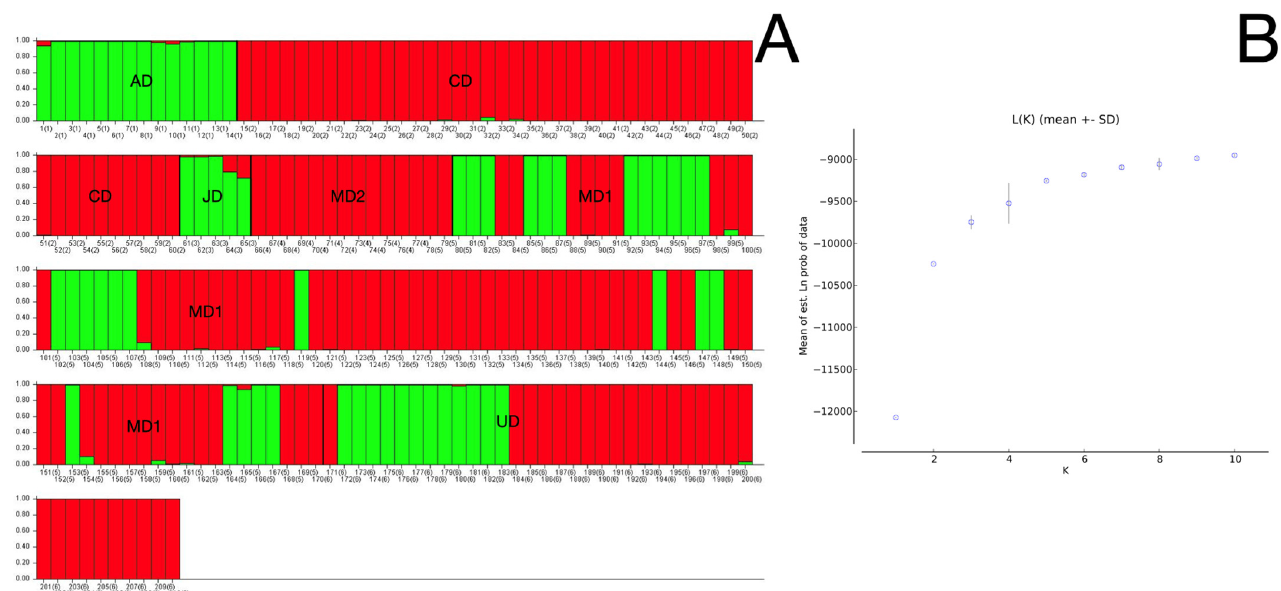
Figure 1. Genetic structure of the T. truncatus populations analyzed in this study (four putative geographic populations and one population with unknown geography). ( A ) Bar plot of the several individuals analyzed; each vertical line ( x -axis) is a single individual with colors representing each cluster’s membership proportion. Colors (red and green) represent the subpopulations conforming to the putative geographic origin ( B ) Mean L(K) ± SD over five runs for each K value. Note: AD: Australian dolphins; CD: Cuban dolphins; JD: Japanese dolphins; MD: Mexican dolphins; UD: Unknown dolphins.